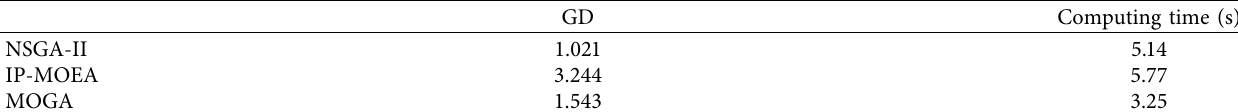
Figure 15: Hypervolumes of three algorithms (median). Table 5: Average GD and computing time of 10 tests.